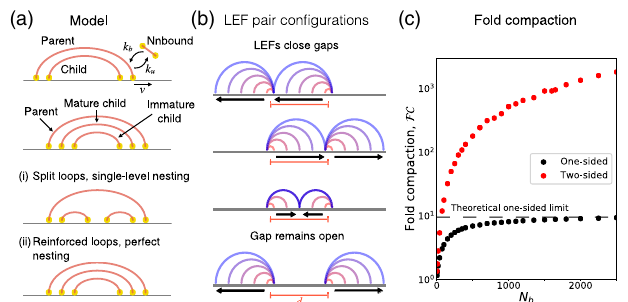
FIG. 2. (a) Top half: A parent LEF is associated with chromatin at the base of an extruded loop, and a child LEF is associated within the loop. A bound LEF can unbind chromatin to become an unbound LEF, and an unbound LEF can bind to become a parent or child. A mature child LEF will become a parent LEF if the current parent LEF unbinds, while a more deeply nested “ immature ” child LEF would remain a child. Bottom half: Loop nesting architectures. With (i) single-level nesting, child LEFs split parent loops, while with (ii) perfect nesting, child LEFs reinforce the parent loops. (b) Possible configurations of pairs of adjacent one-sided LEFs, each shown at different times indicated by color from red (early) to blue (late). The side of extrusion (and direction of motor translocation) is indicated by arrows. The one configuration in which active LEF subunits translocate away from each other by extruding chromatin from opposite sides of the polymer leaves a gap. (c) Simulation results for fold compaction FC by one-sided extrusion (black) and two-sided extrusion (red), shown for varying number of bound LEFs, N